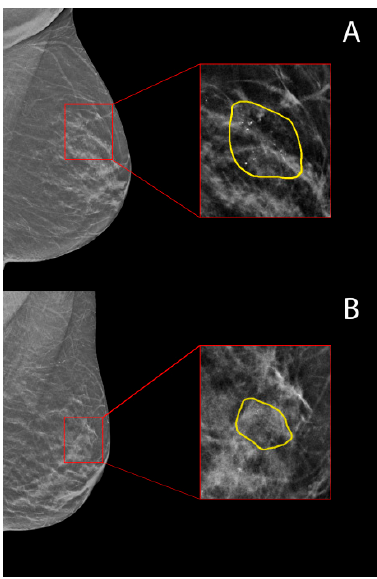
Figure 1. Manual segmentation of the Region Of Interest (ROI) on digital breast tomosynthesis (DBT) images for: ( A ) a malignant calcification, and ( B ) a benign calcification, according to their histopathological reports (DBT-guided vacuum-assisted biopsy (VAB)) and follow-up.